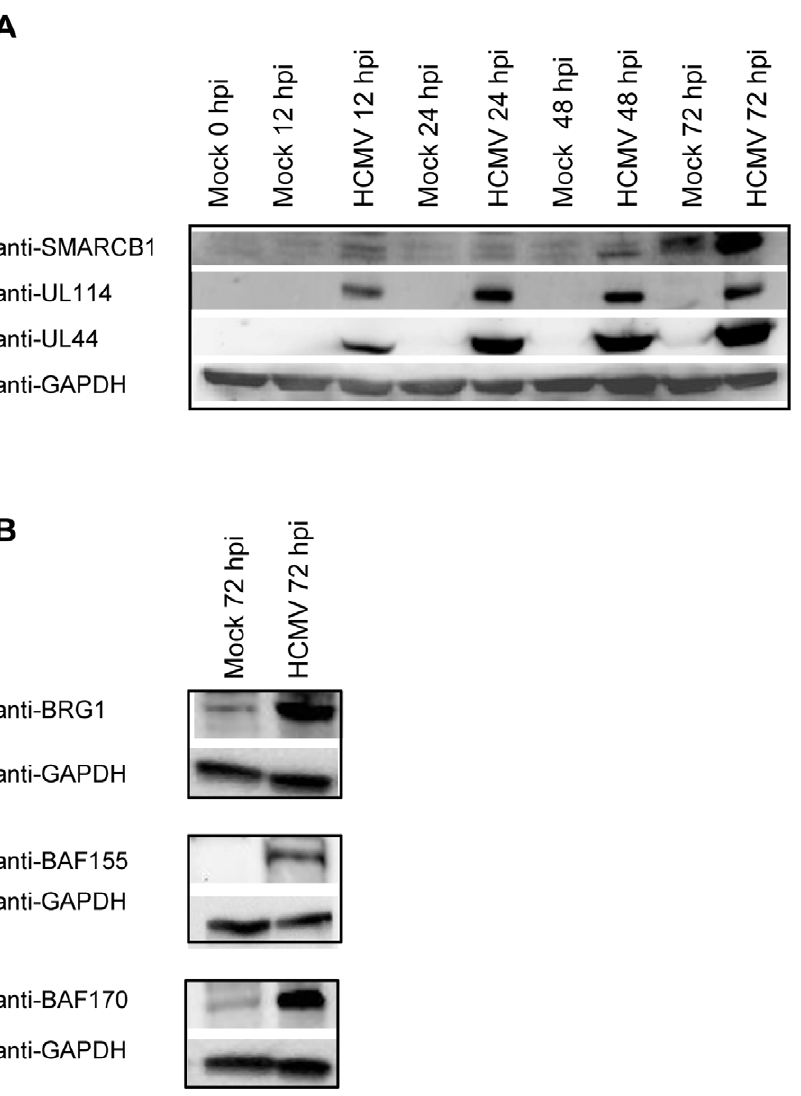
Figure 4. Increased expression of the SWI/SNF core subunits in HCMV infected cells. ( A ) The expression of UL114, SMARCB1 and UL44 in nuclear extracts (20 m g) from mock and HCMV-infected fibroblast cells was analyzed at immediate –early (12 hpi), early (24 hpi) and late (48 and 72 hpi) times of infection by western blot. The western blots were analyzed by Thyphoon scanning. GAPDH was used as a loading control. ( B ) The expression of BRG1, BAF155 and BAF 170 in nuclear extracts (40 m g) from mock and HCMV-infected fibroblast cells was analyzed at late (72 hpi) time of infection by western blot. The western blots were analyzed by Thyphoon scanning. GAPDH was used as a loading control.